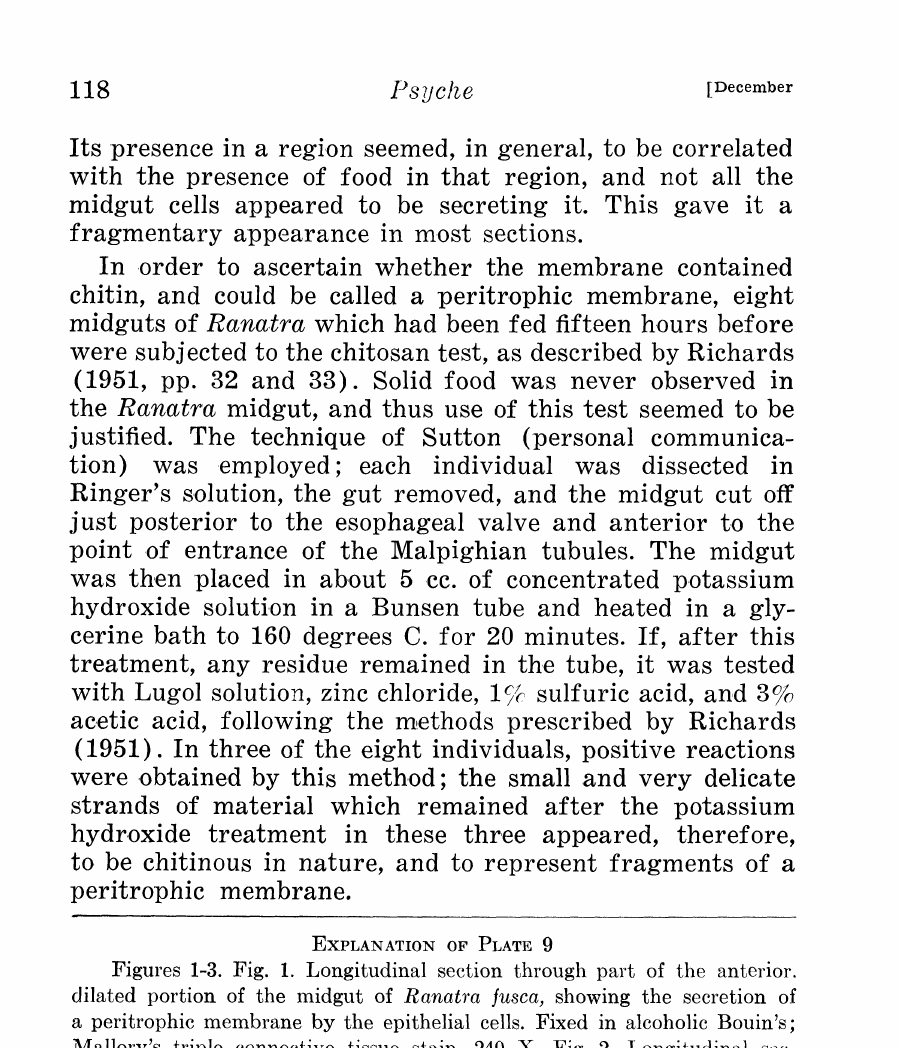
Figures 1-3. Fig. 1. Longitudinal section through part of the anterior. dilated portion of the midgut of Ranatra ]usca, showing the secretion of a peritrophic membrane by the epithelial cells. Fixed in alcoholic Bouin’s; Mallory’s triple connective tissue stain. 240 X. Fig. 2. Longitudinal sec- tion through the posterior part of the midgut of Hesperocorixa interrupta. Note the large fragment, presumably an ingested piece of arthropod exo- skeleton, within the food mass. Fixed in aqueous Bouin’s; Mallory’s triple connective tissue stain. 440 X. Fig. 3. Detail of the fragment shown in Figure 2. Note the sculpturing on the surface of the fragment. 720 X. ABBREVIATIONS USED IN FIGURES. C-Fragment of exoskeleton within food mass. E-Midgut epithelium. F-Food material in gut. L-Lumen of gut. M-Peritrophic